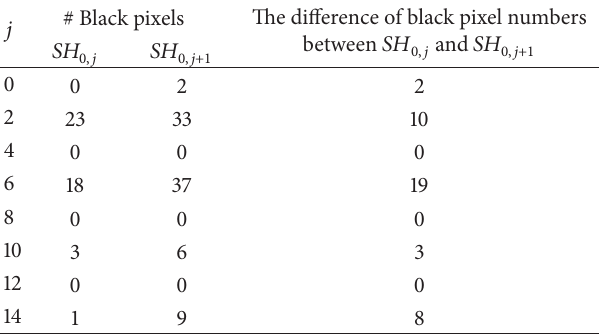
Table 1: The black pixel numbers of eight sub-subimage pairs in the bottom-left subimage of Figure